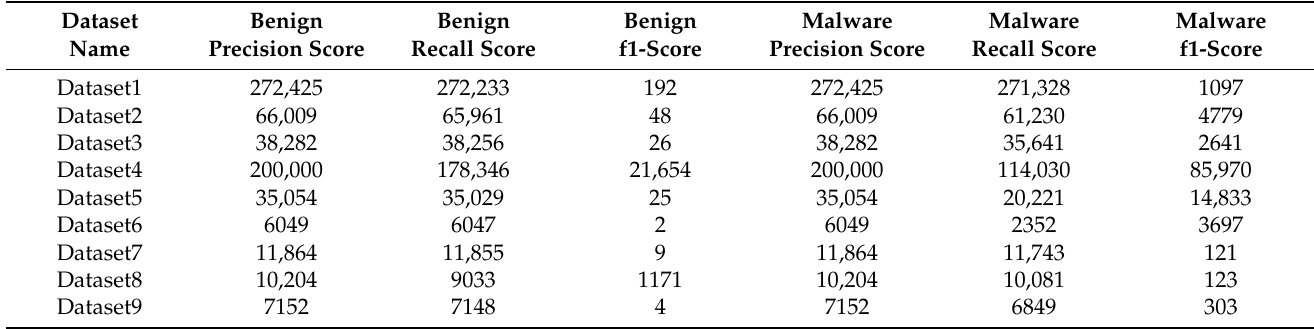
Table 15. Confusion matrix for testing the RF algorithm with minimum